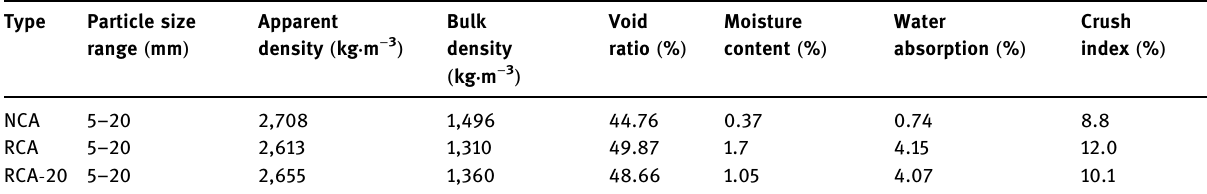
Table 1: Coarse aggregate performance indicators